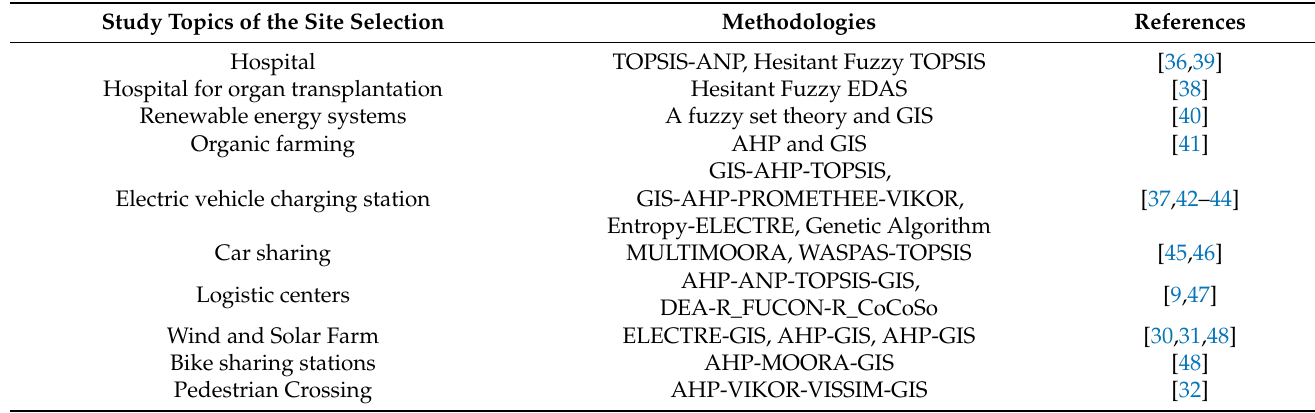
Table 1. Application of various techniques in solution of site selection problems. Study Topics of the Site